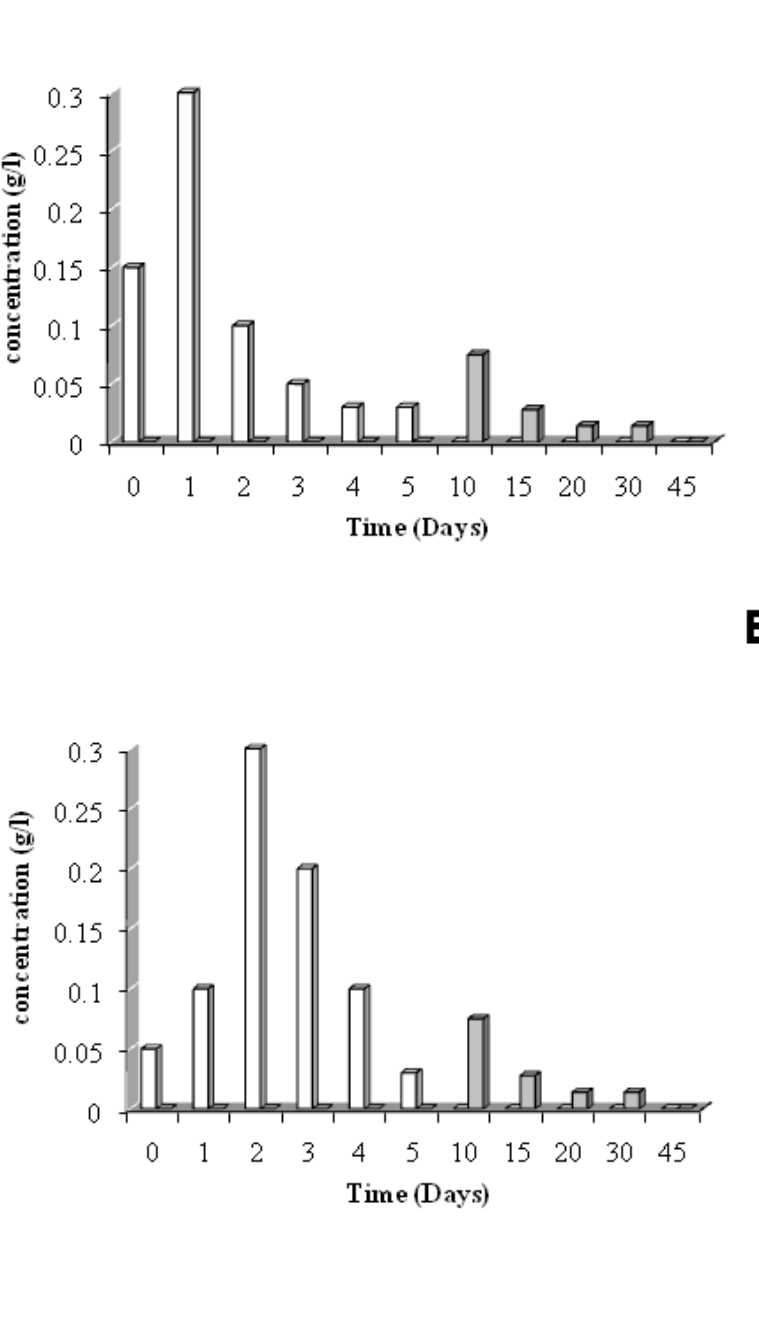
Figure 6. Evolution of some released soluble products (glucose ( □ ) and acid lactic ( ■ )) during the degradation of co-extruded material in activated inert solid medium (A) and in no activated inert solid medium